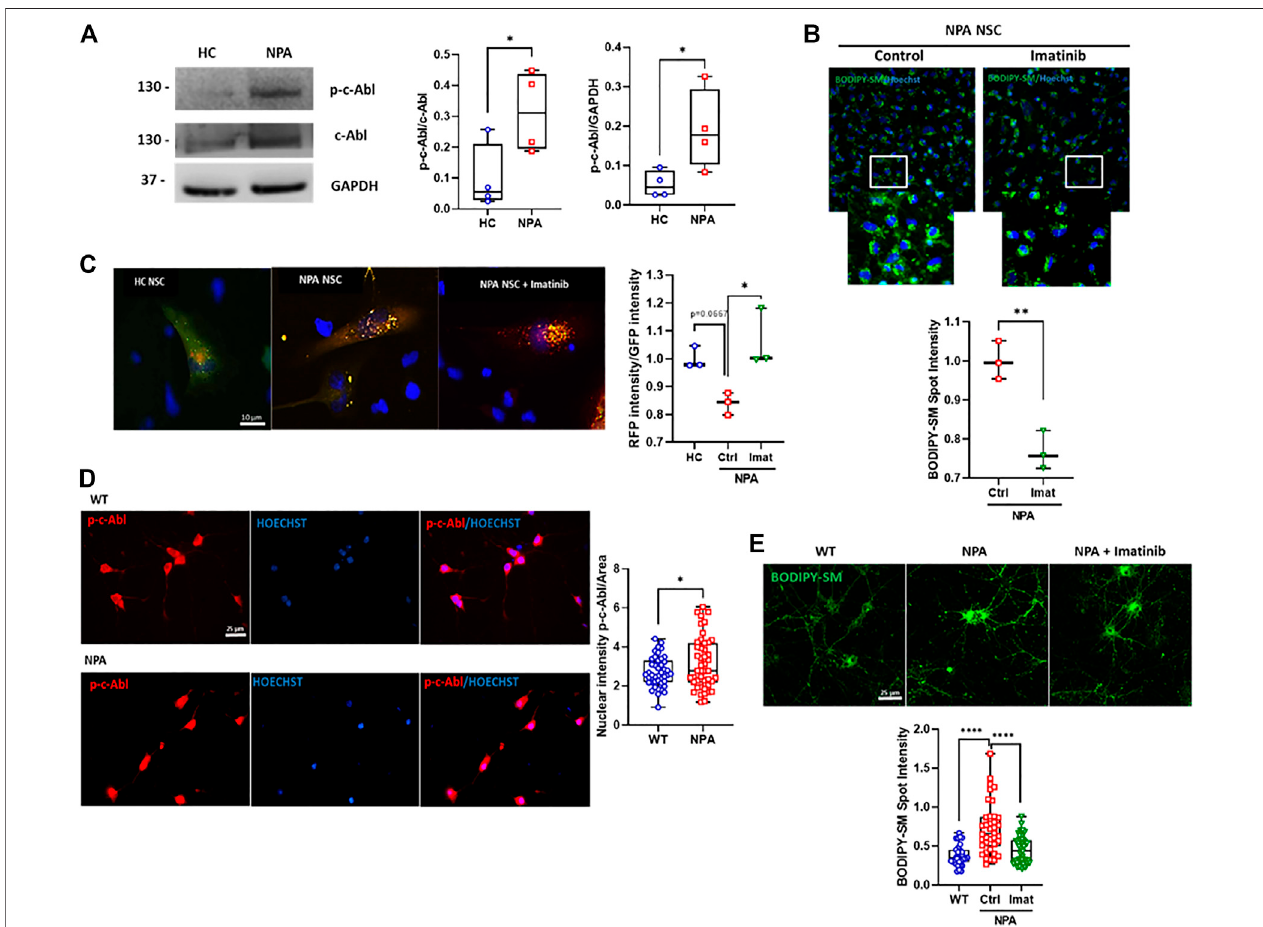
FIGURE 2 | c-Abl inhibition improves autophagy fl ux and decreases sphingomyelin accumulation in NPA neuronal models. (A) p-c-Abl levels were measured in Neural Stem Cells (NSCs) extracts by Western blot. Images representative from four independent experiments are shown. Student ’ s t -test: * p < 0.05. (B) BODIPY-SM stainingindicatessphingomyelinaccumulation.FluorescentmicroscopicimagesofNPANSCstreatedimatinib0.001 µMby24 h.Foreachcondition, n =150cellswere measured by experiment; three independent experiments were performed. Student ’ s t -test: ** p < 0.01. (C) NPA NSCs expressing mRFP-GFP-LC3 were treated with imatinib 0.001 µM by 24 h or vehicle. Graph shows the rate between RFP intensity and GFP intensity corresponding to autolysosomes. For each condition, n = 50 cells were measured by experiment; three different experiments were performed. Student ’ s t -test: * p < 0.05. (D) Primary neurons were 7 days in vitro , fi xed, and immunostained using anti-p-c-AblTyr412 antibody (red) and Hoechst stainingfornucleus (blue). Foreach condition, n = 10 – 20neurons weremeasured byexperiment; three independent experiments were performed. Student ’ s t -test: * p < 0.05. (E) Primary hippocampal neurons were treated with imatinib 5 µM by 24 h. Sphingomyelin accumulation was analyzed by BODIPY-SM. For each condition, n = 10 – 20 neurons were measured by experiment; three independent experiments were performed. ANOVA,Tukey post-hoc :**** p < 0.0001.Inthebox-and-whiskerplots,thecenterlinedenotesthemedianvalue,edgesareupperandlowerquartilesandwhiskersshow minimum and maximum